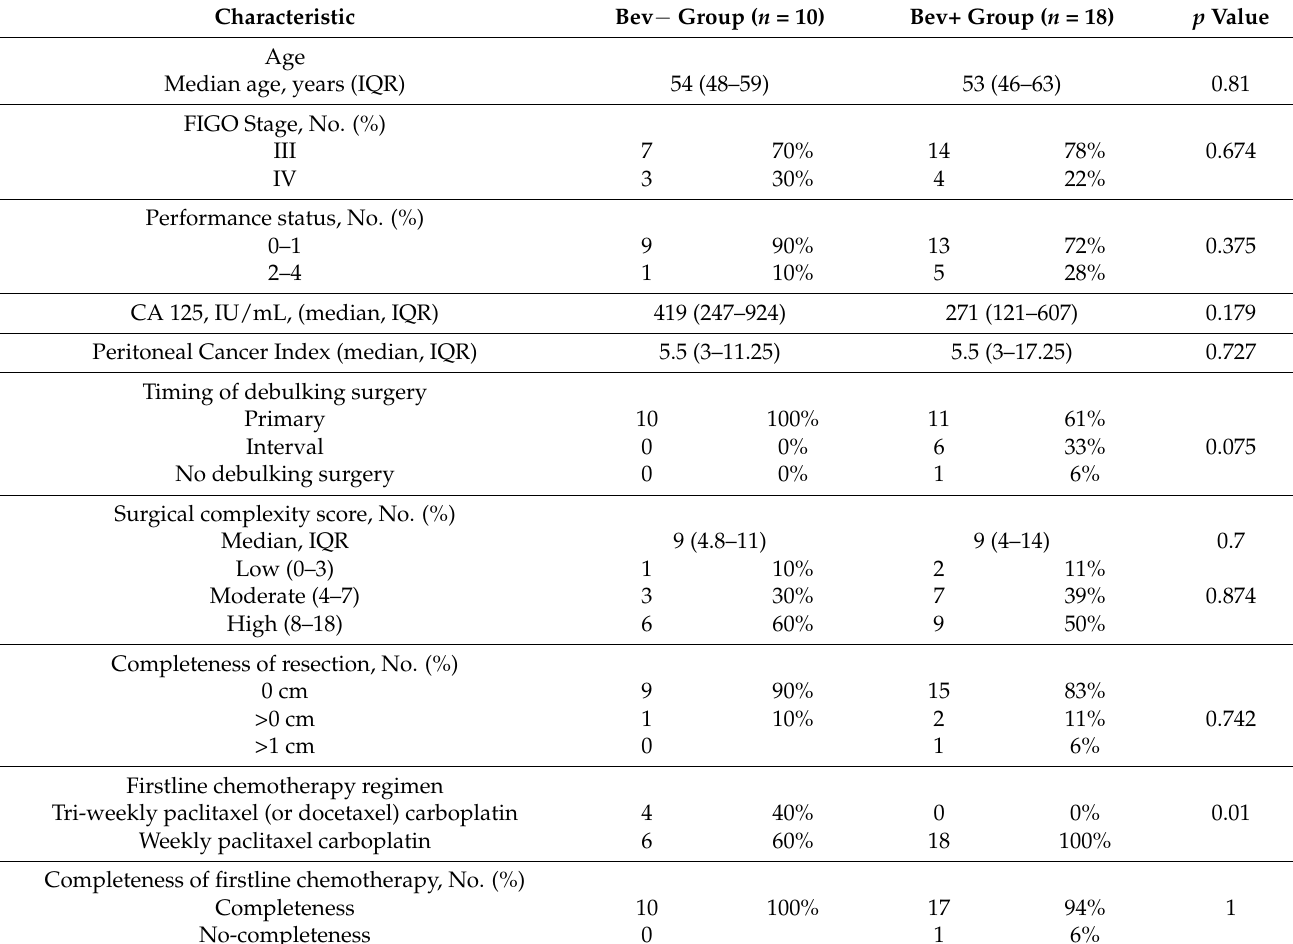
Abbreviations: FIGO, International Federation of Gynecology and Obstetrics; IQR, interquartile range: NACT, neoadjuvant